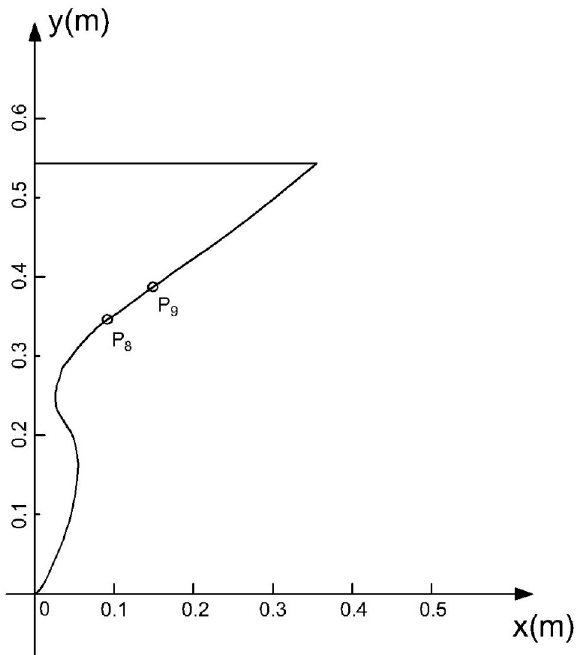
Figure 9. Shape of the bow-flared section in MOERI (2013).